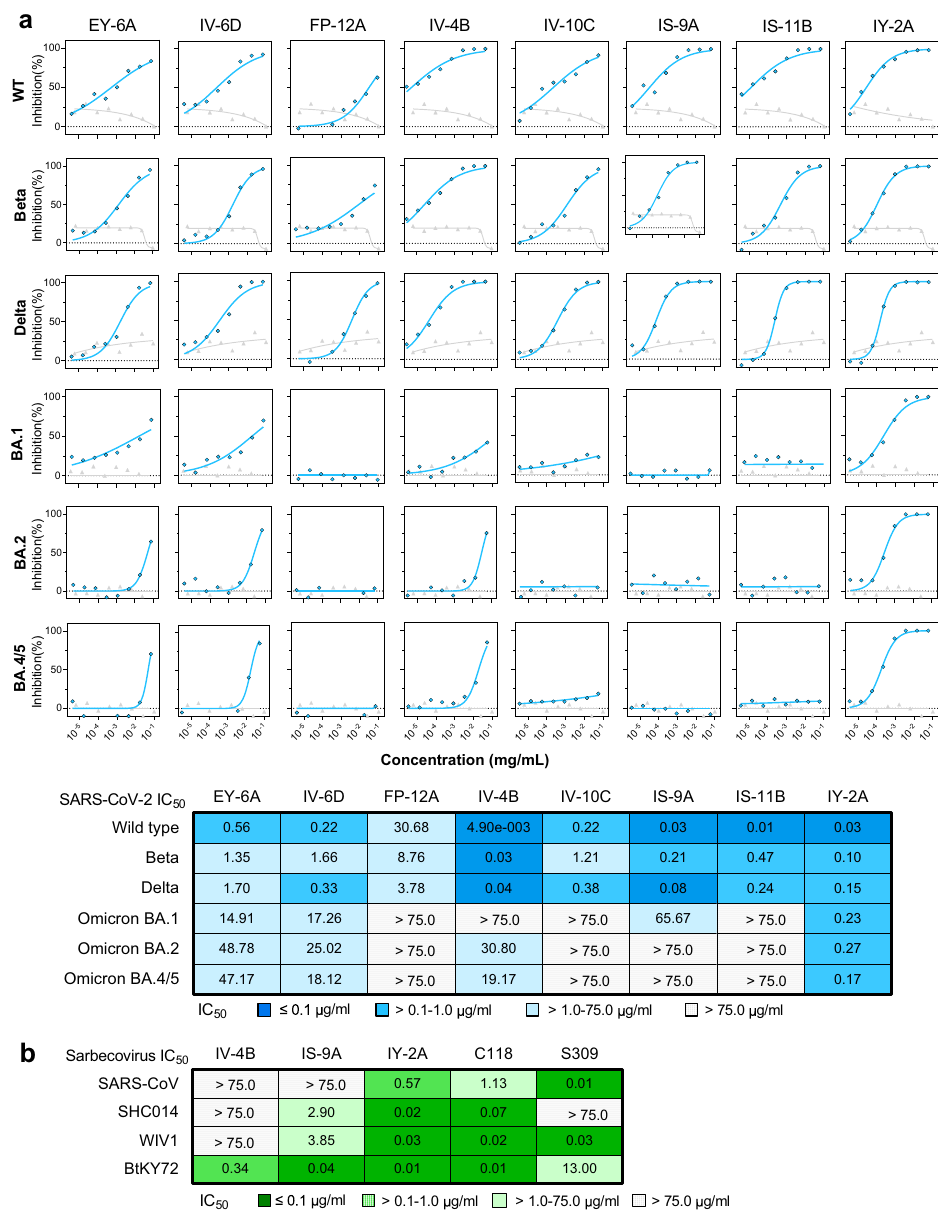
Fig. 2 | Neutralization breath of class 4 antibodies. a Neutralization potency of each antibody against SARS-CoV-2 pseudotyped virus (wild type, Beta, Delta, and OmicronBA.1,BA.2andBA.4/5variants).Graycurvesareanti-in fl uenzaH3mAbBS- 1A as control. Data are mean of technical duplicates ( n =2), and curves are fi t by nonlinear regression for half-maximal inhibitory concentrations (IC 50 values), as summarized in the table below. Each box of the table is colored accordingly: the